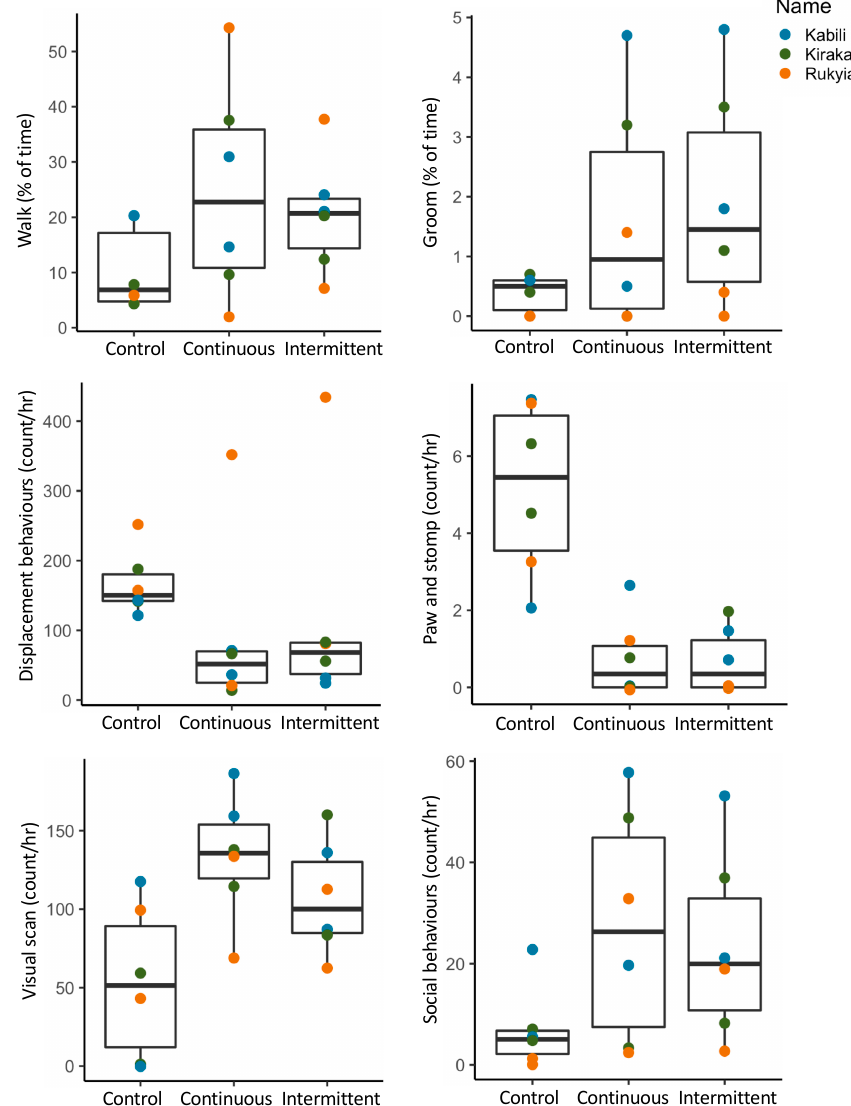
Figure 3. Boxplots of giraffe behavior in control, continuous and intermittent noise conditions, with colors identifying individuals.